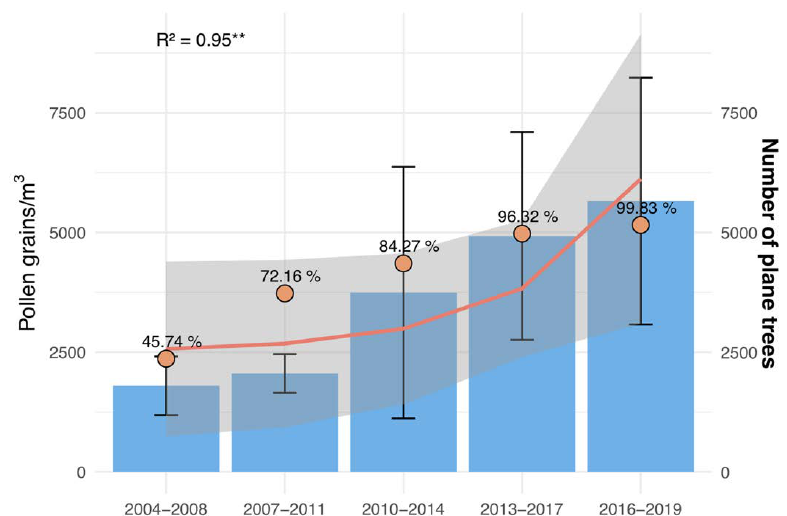
Figure 3. Trends of number of risk days of Platanus pollen ( > 50 pollen grains / m 3 ). Levels of significance: * p < 0.05, ** p < 0.01. Blue line represents the regression line and grey zone corresponds to 95% confidence interval.